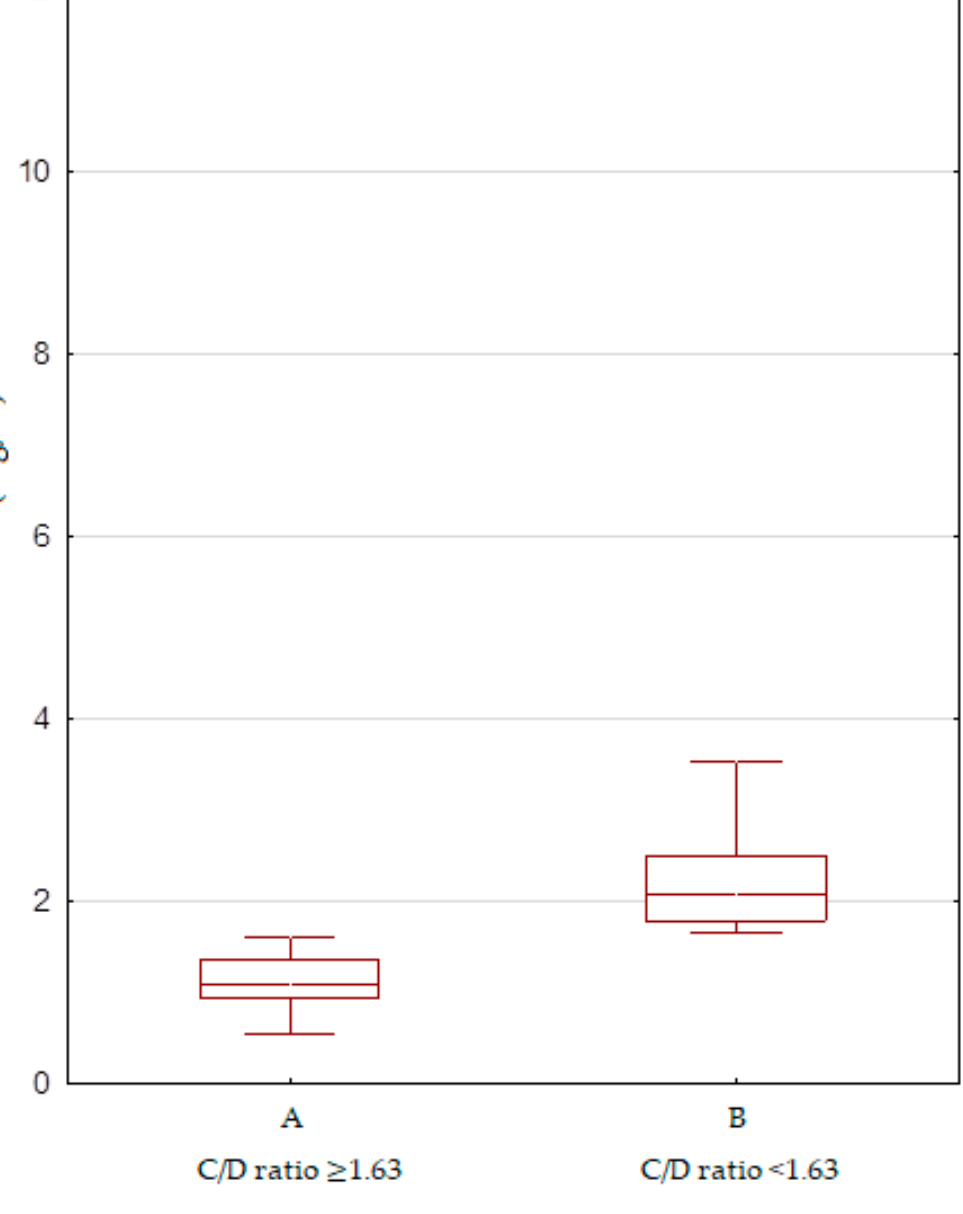
Figure 3. The creatinine concentration from the most recent appointment between the C/D ratio <1.63 ( A ) and ≥ 1.63 ( B ) groups. Significant differences in the creatinine concentration from the most recent appointment between the C/D ratio <1.63 and ≥ 1.63 groups ( p = 0.02, Mann-Whitney U test).